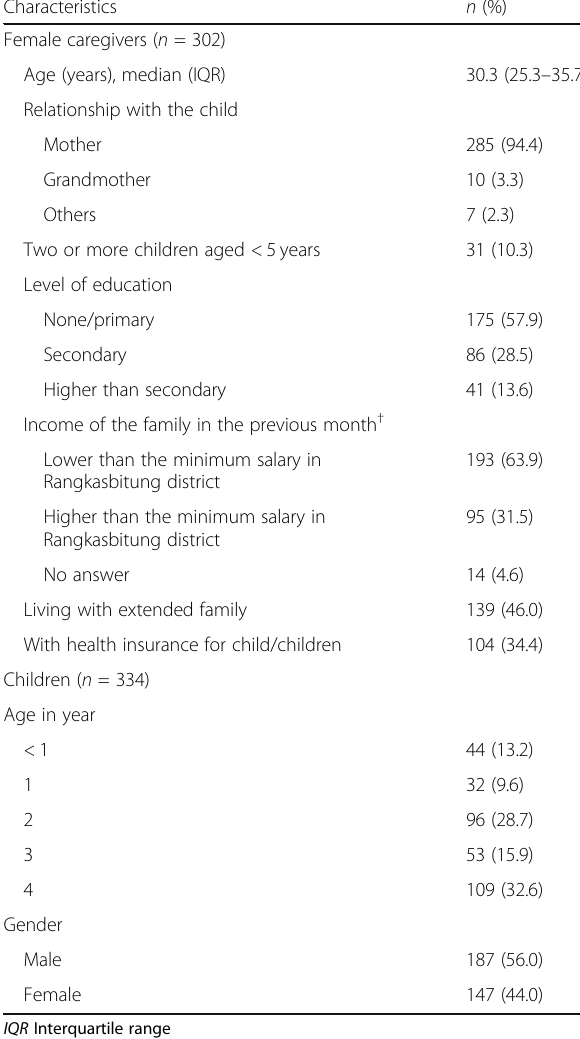
Table 2 Proportion of antibiotic use among children who developed clinical symptoms within the last 30 days ( n =